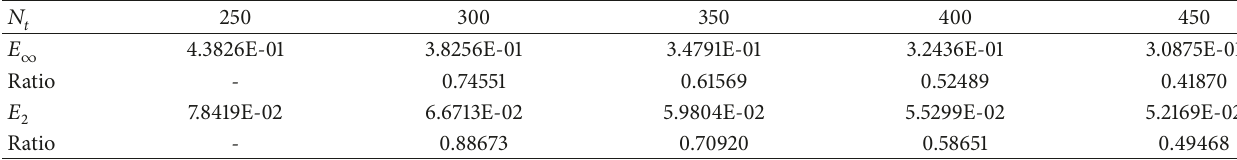
Table 3: Errors and ratios in time of the central difference scheme